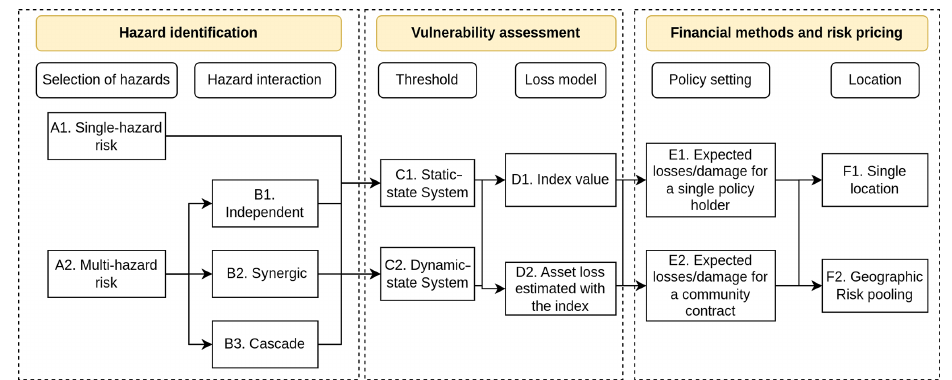
Figure 3. The multi-hazard risk weather insurance design framework. The framework illustrates the process of selecting and prioritizing hazards, defining index thresholds, modeling losses, and optimizing insurance risk premiums. The vulnerability assessment presents two types of systems: (a) stationary-state system, where both thresholds and hazards are stationary and represent an analysis based on observed historical information, and (b) non-stationary-state system, where both indices and hazards are non-stationary and reflect a combination of observed historical and projected data. The non-stationary system anticipates a potential increase in risk and optimizes risk premiums.